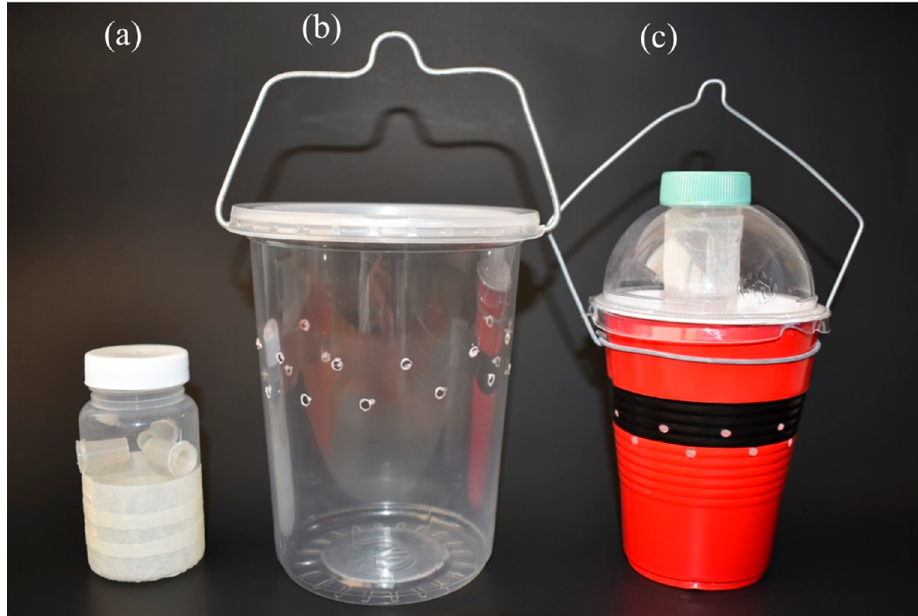
Figure 1. Trap models used in experiments: ( a ) handmade trap (120 mL capacity) used in laboratory cage experiments, ( b ) SAGARPA trap (one-liter capacity), ( c ) 2C trap comprising a cup with drowning solution and a ventilated tube device in the lid.